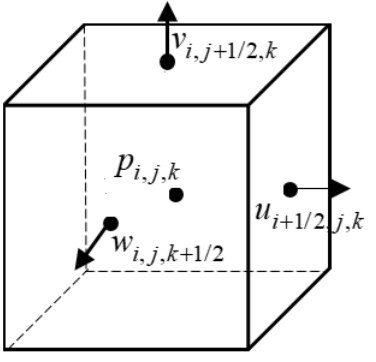
Figure 2. MAC mesh structure.